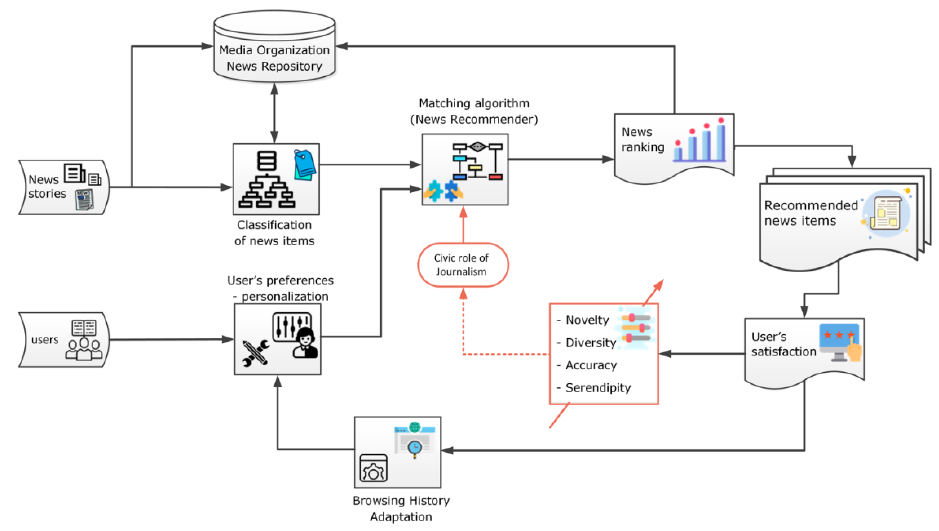
Figure 1. The proposed model incorporates baseline NRS data flows and processes, elaborating on the civic role of journalism (reddish routes) through novel metrics to make the underlying mechanisms more robust and useful.